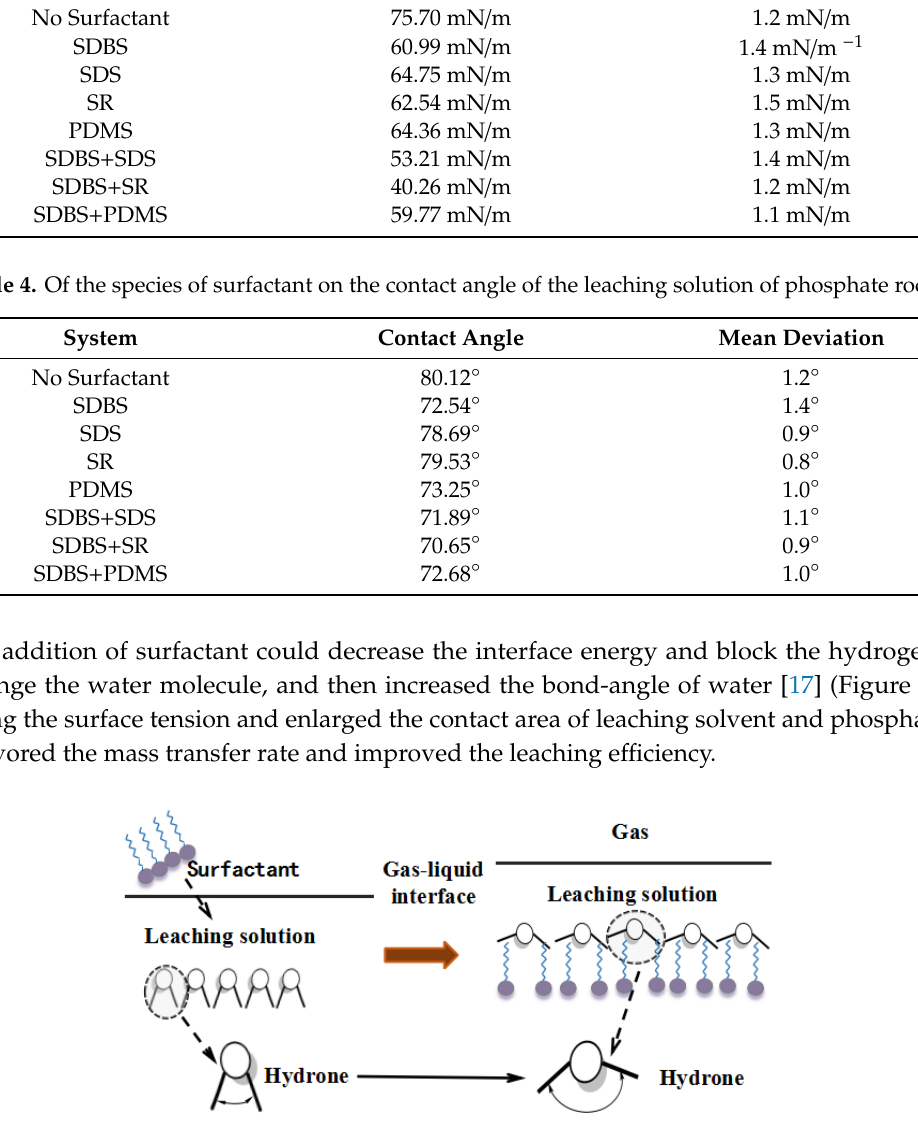
Table 3. Of the species of surfactant on the surface tension of the leaching solution of phosphate rock. System